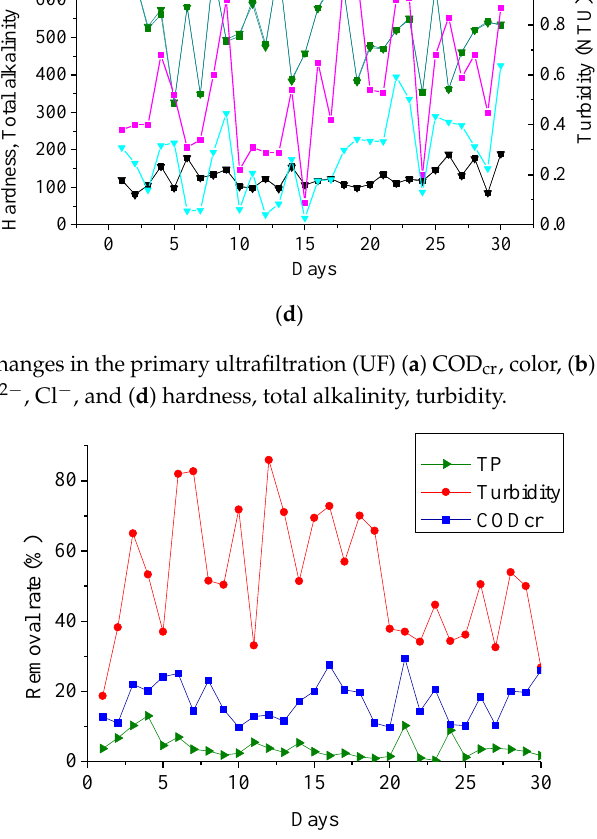
Figure 7. Removal rate of TP, turbidity, and COD cr in the primary UF process . Table 2 . Operating conditions and results from the test carried by the primary reverse osmosis (RO) . The primary RO pressure was controlled between 1.0 – 1.2 MPa to protect stable water yield. Pressure (MPa) (Table 2). The average removal rates of COD cr , color, TP, Cl − , SO 42 − , and conductivity in the primary RO were 99.17 ± 0.88%, 99.11 ± 1.60%, 98.09 ± 1.55%, 92.02 ± 1.87%, 99.17 ± 0.81%, and 92.94 ± 2.49%, respectively. The average removal rates of total alkalinity, NH 3 -N, TN, hardness, and turbidity were